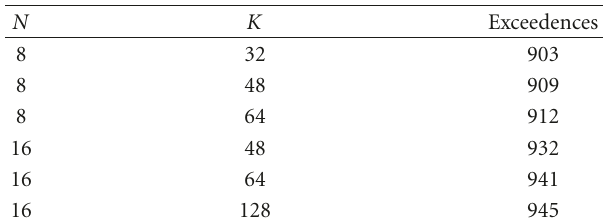
Table 5: Performance of the NHD for μ = 1 and ν = 0 . 5 in nonhomogeneous